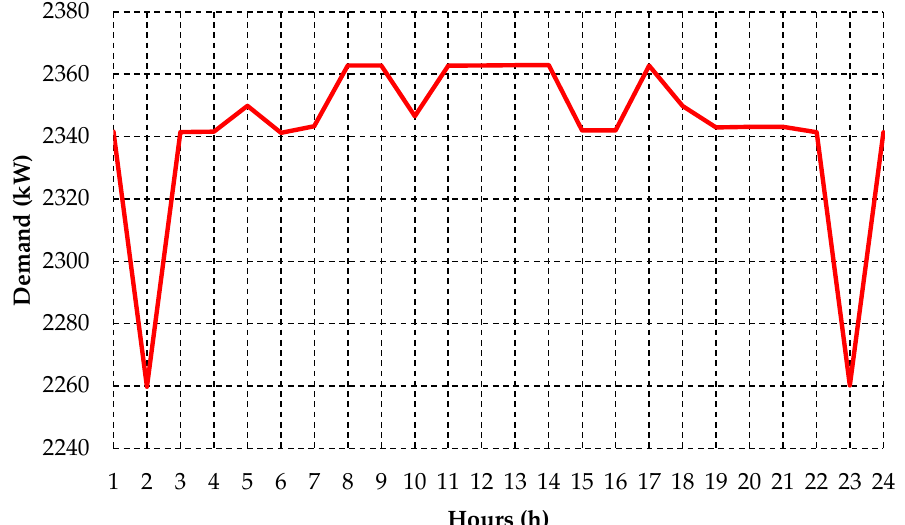
Figure 19. Daily demand profile of irrigator customers resulting from load shifting at the Rural Feeder B.